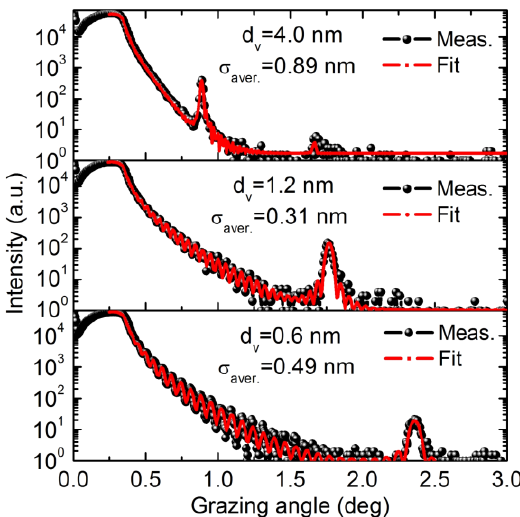
Figure 2. The experimental reflectivity (circles) versus the grazing incidence angle of Cr/V multilayers with the same (1.3 nm) thickness of Cr layers, while varying (from 0.6 nm up to 4 nm) thickness of V layers. The solid curves are the results of fitting.